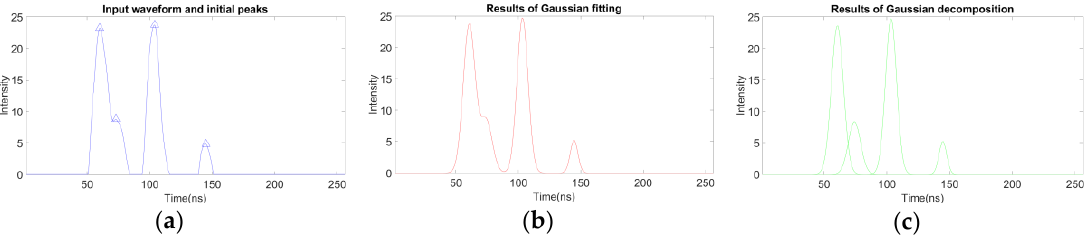
Figure 2. The illustration of Gaussian decomposition: ( a ) Input waveform and initial peaks; ( b ) Results of Gaussian fitting; ( b ) Results of Gaussian decomposition.